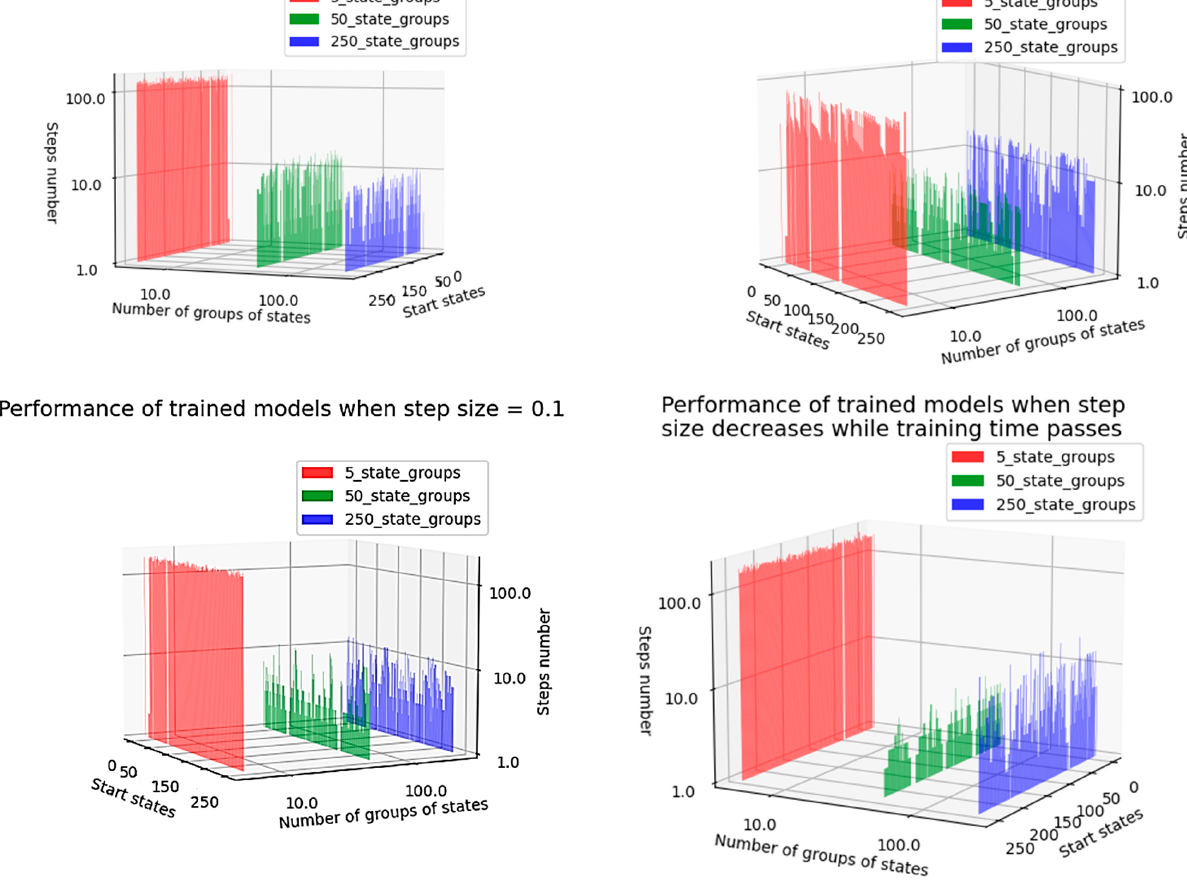
Figure 11. Influence of state grouping on agents’ training efficiency for several step-size settings.